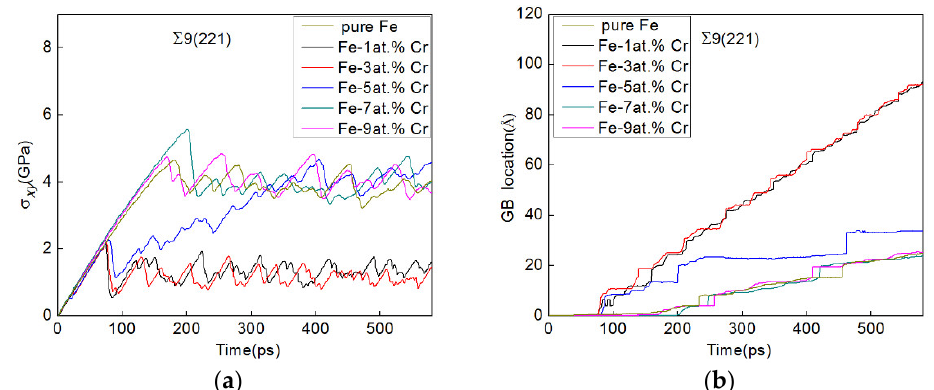
Figure 4. Shear process of the Σ9(221) GB in pure Fe and Fe-X at.% Cr alloys (X = 1, 3, 5, 7, and 9). ( a ) shear stress (σ xy )-time curves and ( b ) GB location-time curves.